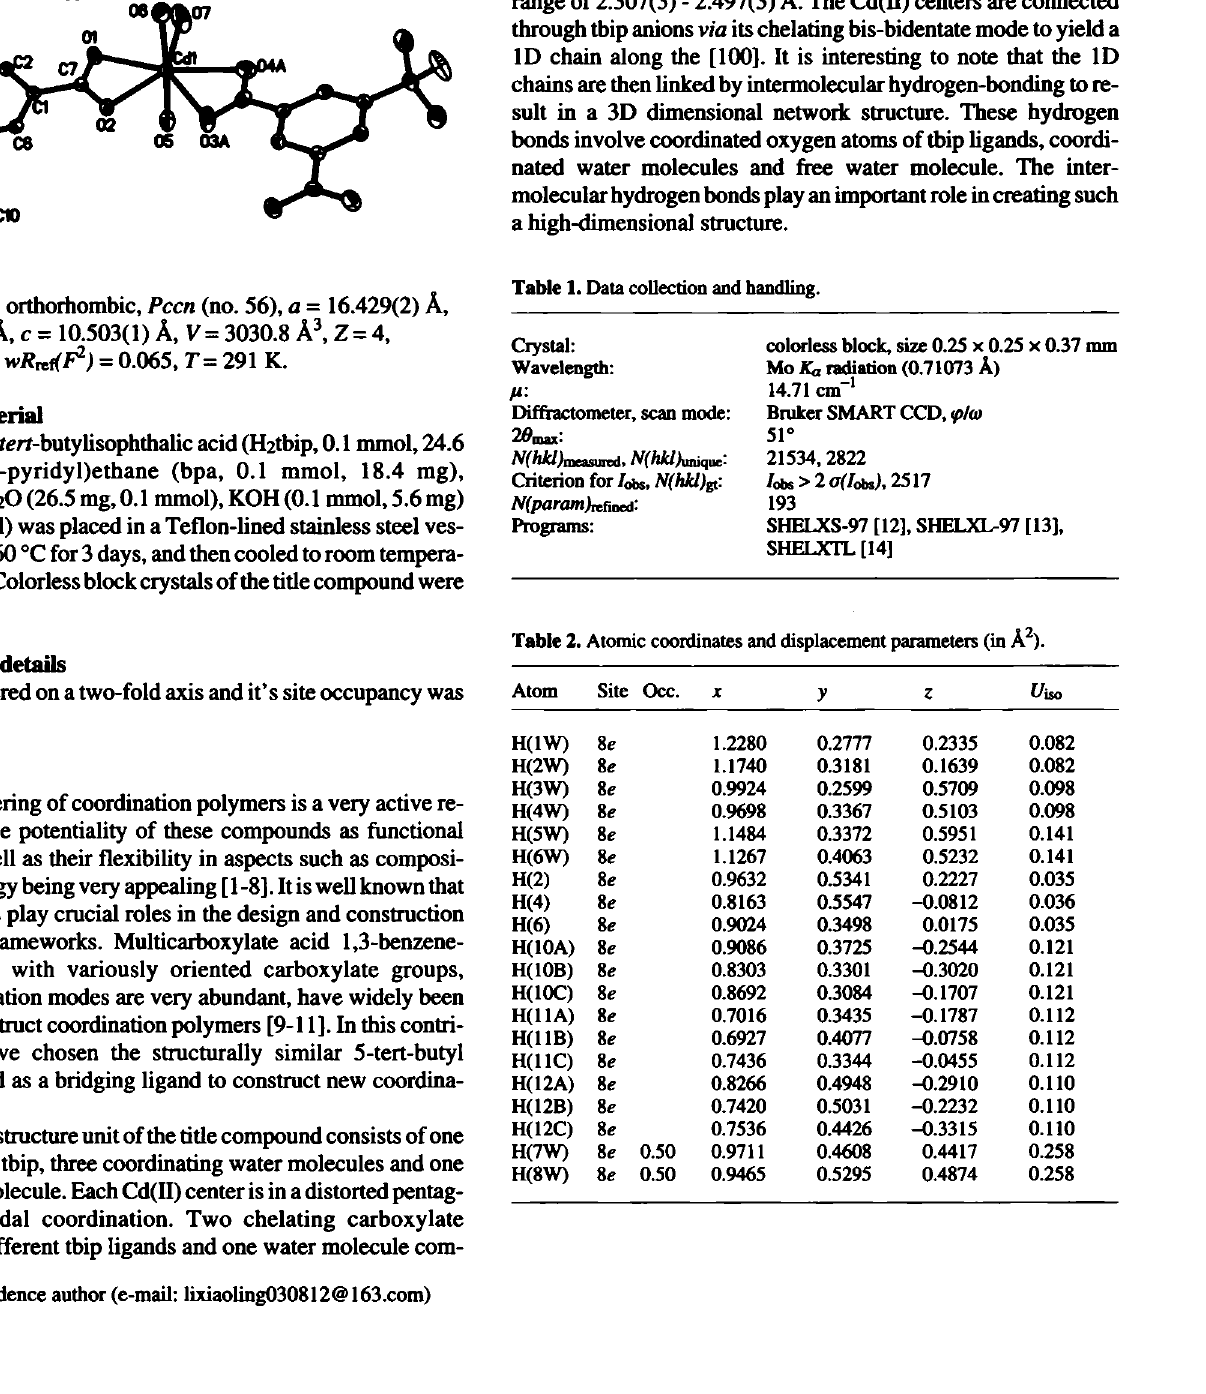
Table 1. Data collection and handling.